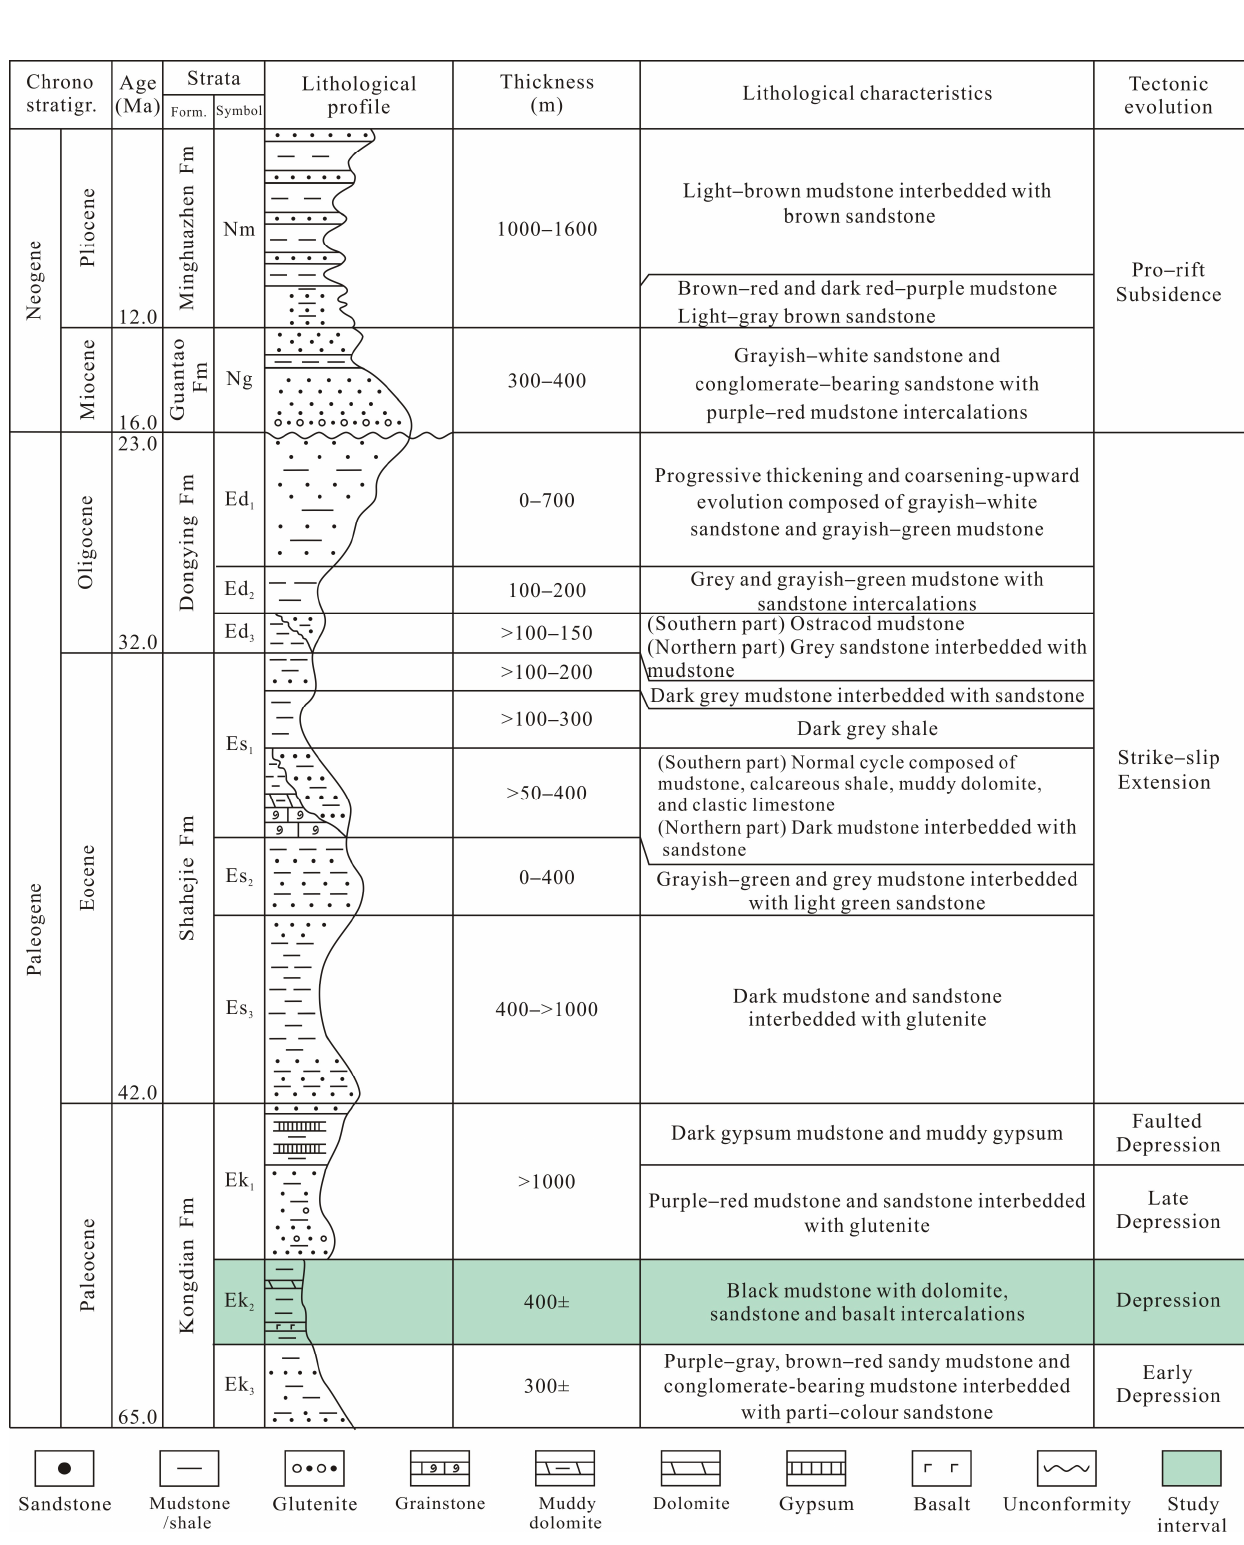
Figure 2. Composite stratigraphic column of Paleogene and Neogene strata in the Cangdong Sag, Bohai Bay Basin, China (modified from [24–26]).